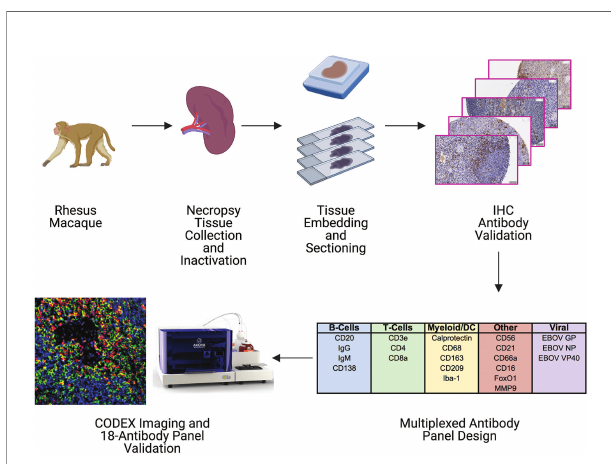
FIGURE 1 | Pipeline for building a CODEX antibody panel for studying tissue immune responses during EBOV infection in rhesus macaques. Spleen tissues were collected from control and EBOV challenged rhesus macaques, inactivated by fi xation, embedded in paraf fi n blocks, and sectioned. A panel of antibodies targeting host immune cells and EBOV proteins was tested by immunohistochemistry (IHC) to determine compatibility with epitopes following inactivation. Antibodies with acceptable staining performance by IHC were conjugated to unique DNA oligonucleotide tags and pooled to create a 21- plex CODEX antibody panel. CODEX antibody panel validation was accomplished by staining tissues with the entire antibody panel cocktail and examining orthogonal staining patterns of antibody channels after